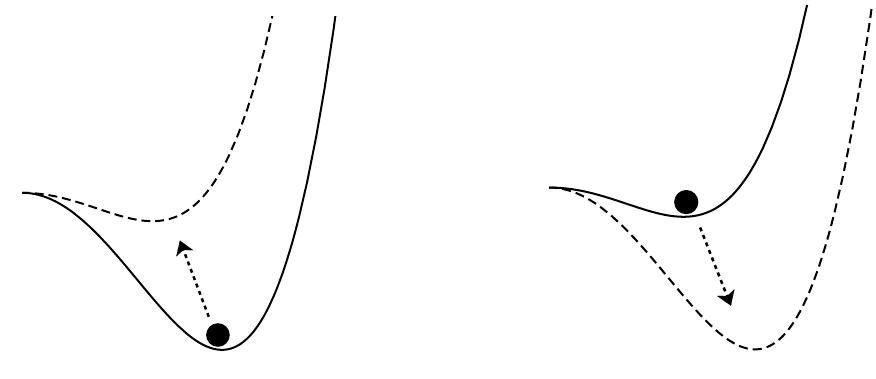
Figure 1 . Illustration of the e(cid:11)ective Higgs potential from the end of in(cid:13)ation (solid-curve) to preheating (dashed-curve). Left panel: the Higgs (cid:12)eld starts to roll down towards the origin due to the decrease of the barrier (free-fall relaxation). Right panel: the Higgs (cid:12)eld starts to roll away from the origin due to the enhancing barrier from the tachyonic mass term (forced